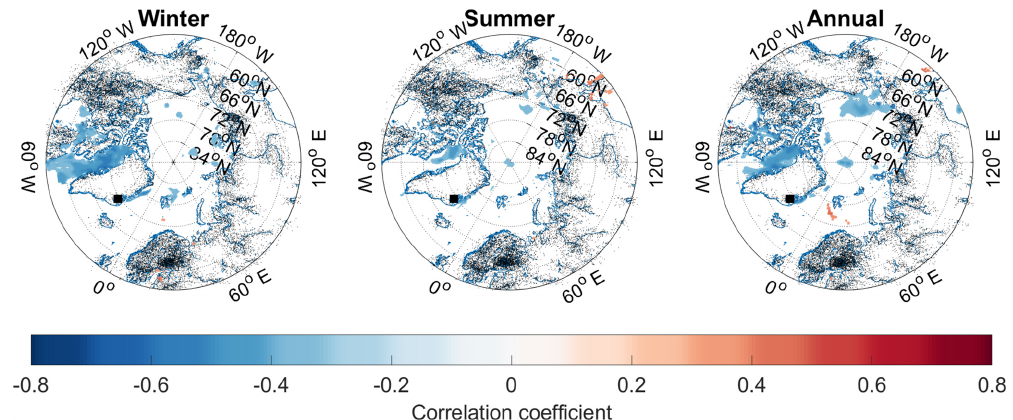
Figure 13. Maps showing the correlation coefficients between the ERA-Interim sea ice concentration and the RECAP δ 18 O data for the 1980–2014 period ( p < 0 .